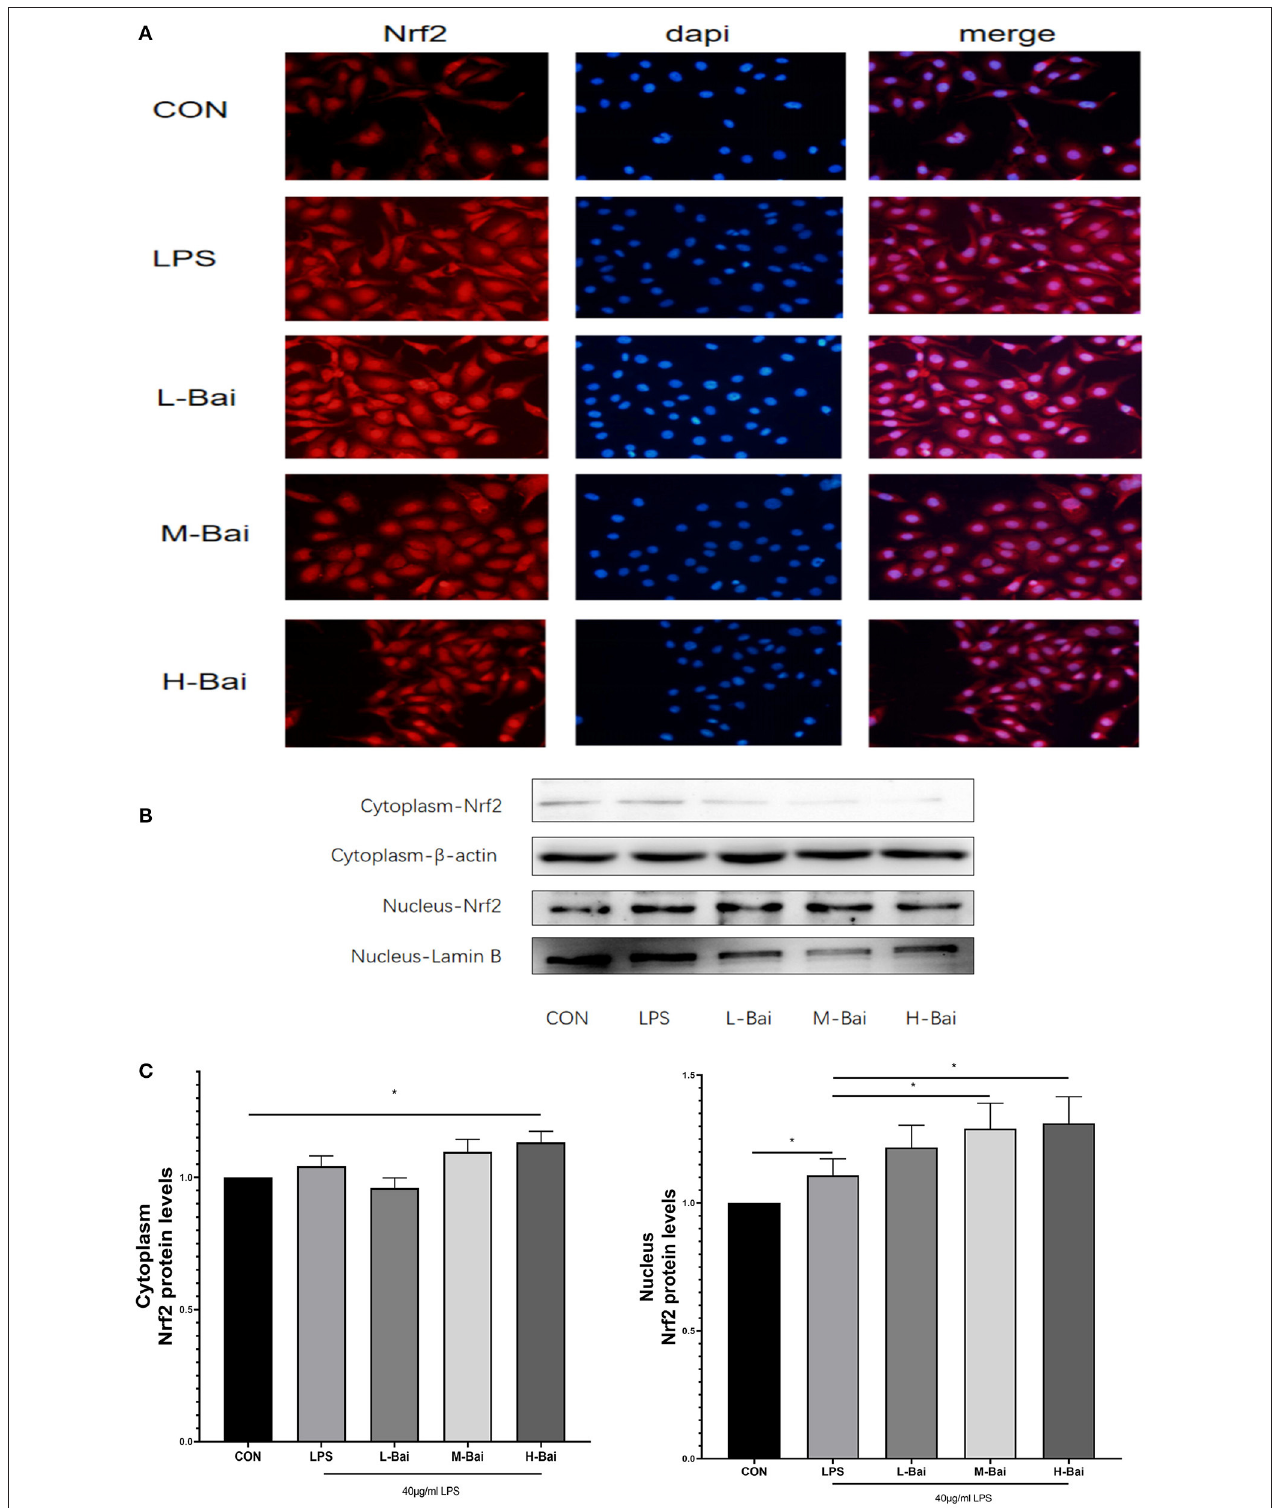
FIGURE 6 | Effects of baicalin on key proteins in the Nrf2 signaling pathway in LPS-stimulated IPEC-J2 cells. Immunofluorescence detection of nuclear Nrf2 protein import in IPEC-J2 cells (A) . Western blotting was used to determine the expression of HO-1, Nrf2, β -actin, and lamin B (B) . Cytoplasmic and nuclear Nrf2 protein expression (C) . Data are presented as the mean ± SEM ( n = 3 per treatment, * p < 0.05 compared with the model group). CON, control; L-Bai, low-concentration baicalin; M-Bai, middle-concentration baicalin; H-Bai, high-concentration baicalin.